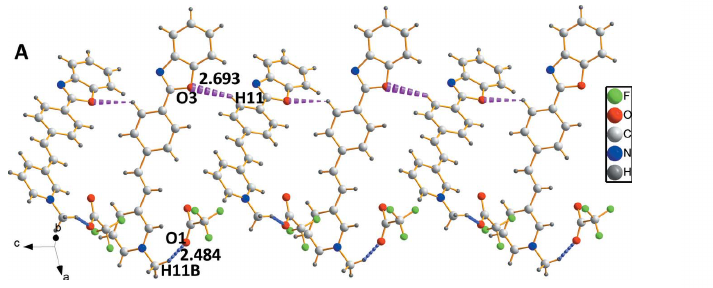
Figure 3 The unit-cell